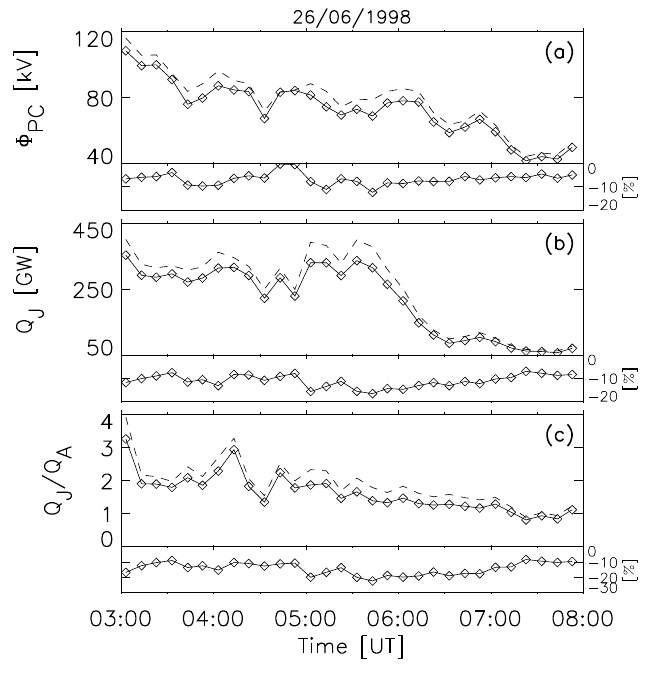
Fig. 5. (a) Polar cap potential drop 8 PC , (b) Joule heating rate Q J and (c) the ratio Q J /Q A between Joule heat- ing and energy flux estimated through- out the time interval between 03:00 and 08:00 UT on 26 June 1998. The parameters have been calculated with- out (dashed line) and with (solid line) PIXIE data. The differences in per- cent when including PIXIE measure- ments are also